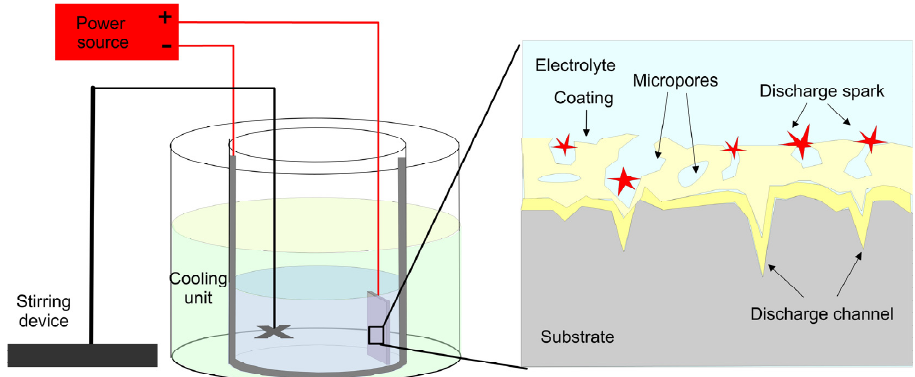
Figure 7. A scheme of MAO device (A) and growth model presenting the formation of MAO coating with complex